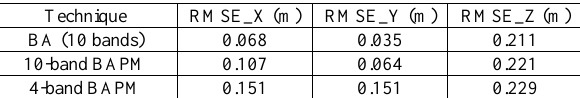
Table 7. RMSE in four checkpoints resulting from the indirect image orientation with BA and BAPM.